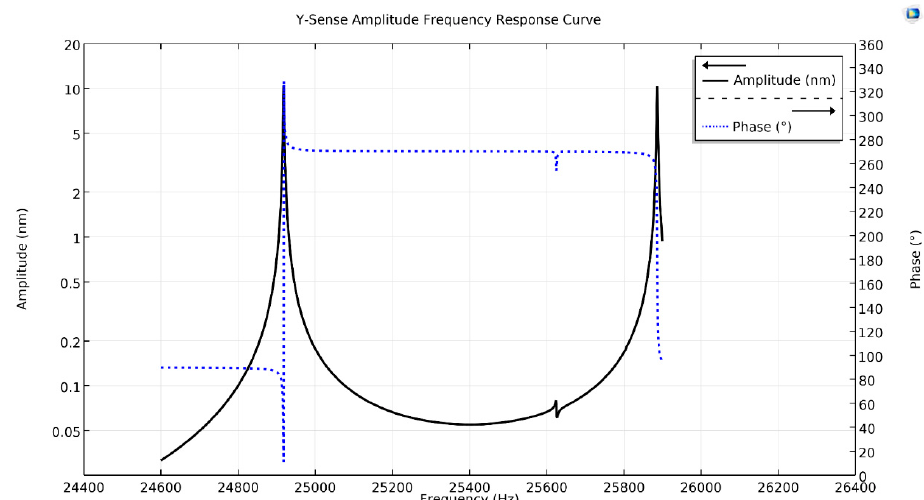
Figure 6. Y-sense amplitude frequency response curve of the proposed single-drive, 3-axis MEMS gyroscope. Micromachines 2020 , 11 , x FOR PEER REVIEW 9 of 13